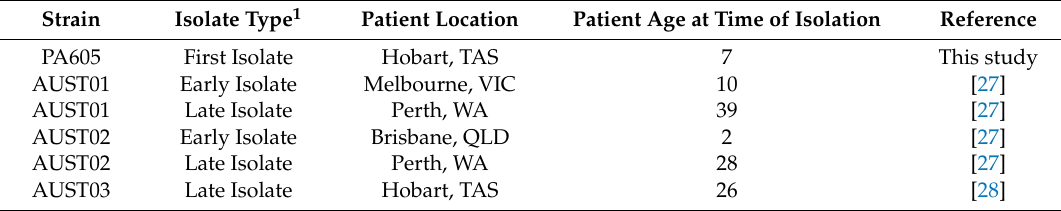
Table 2. Properties of P. aeruginosa clinical isolate strains used in this study.